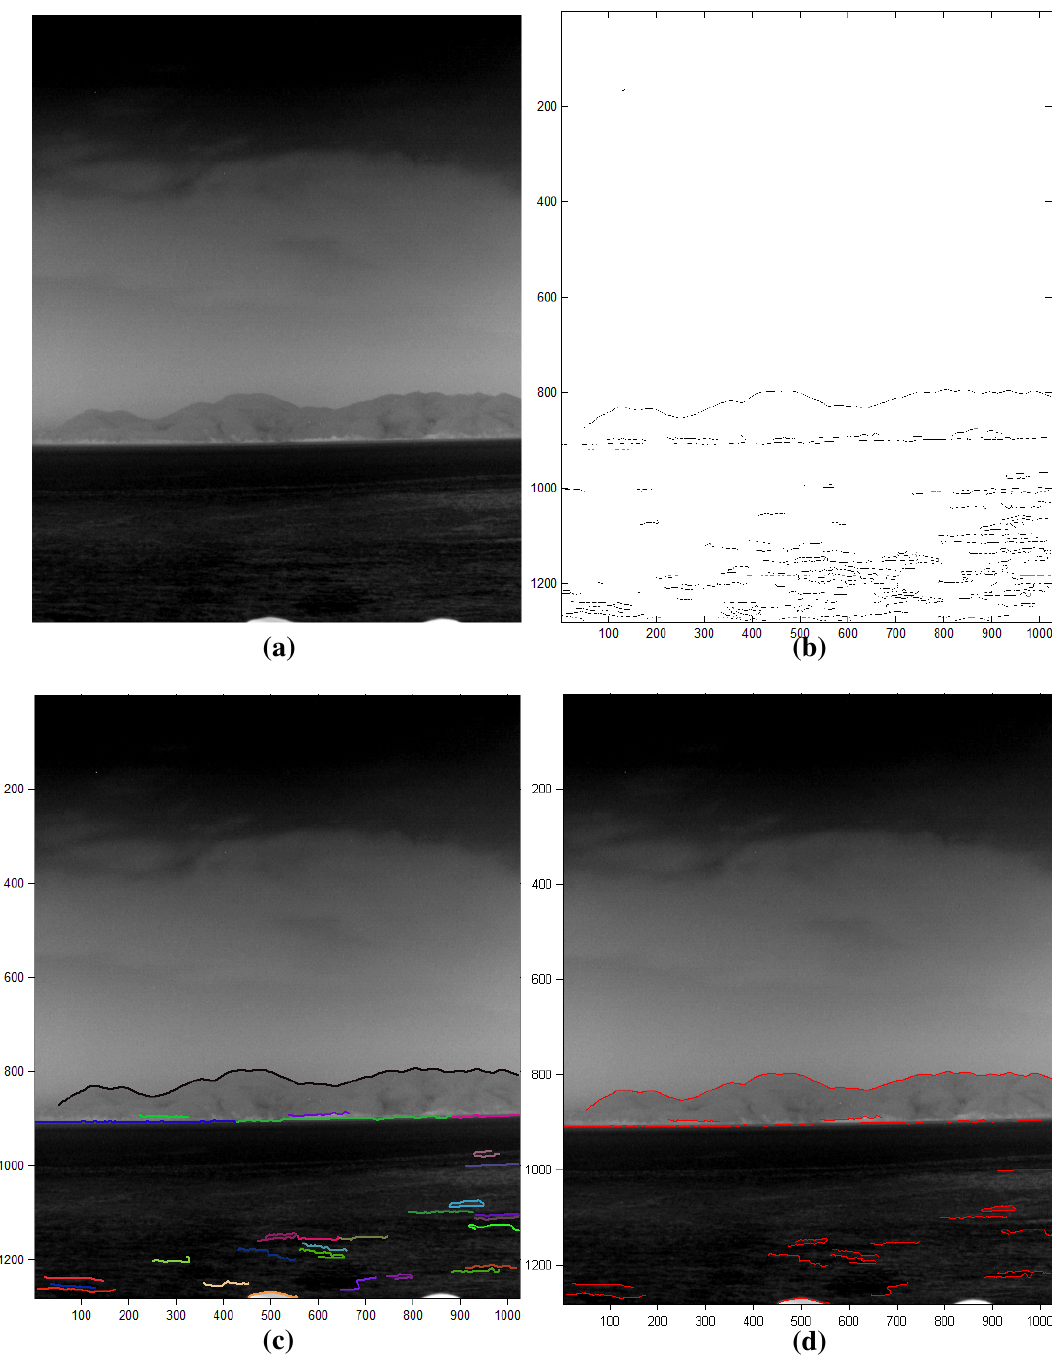
Figure 17. Results of curve map extraction: ( a ) test image; ( b ) initial raw edge map by Canny edge detector; ( c ) contour extraction with a gap size of 2; ( d ) final curve map by removing the short